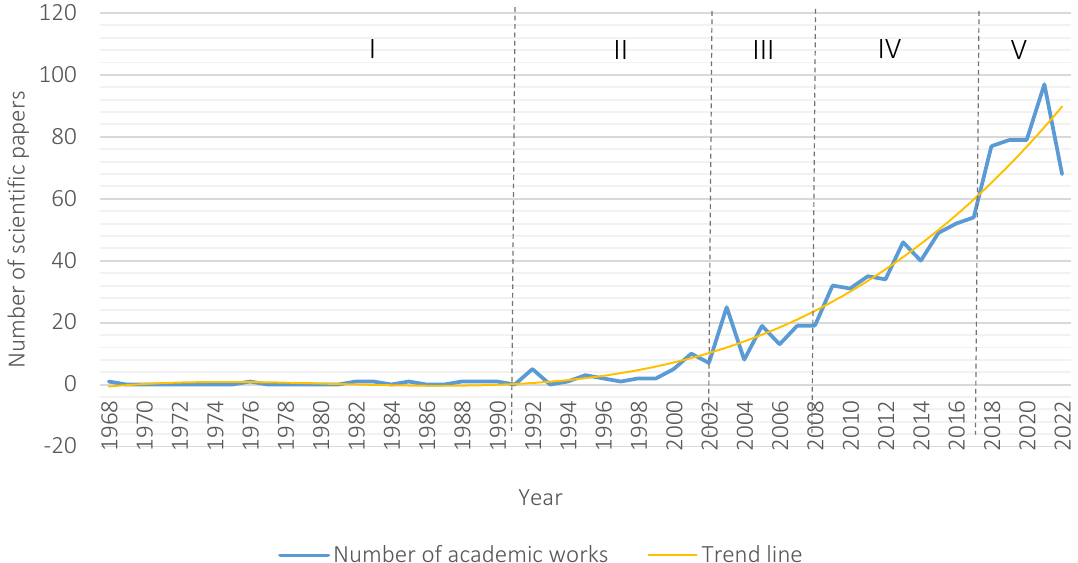
Figure 1. Publishing trends in public sector